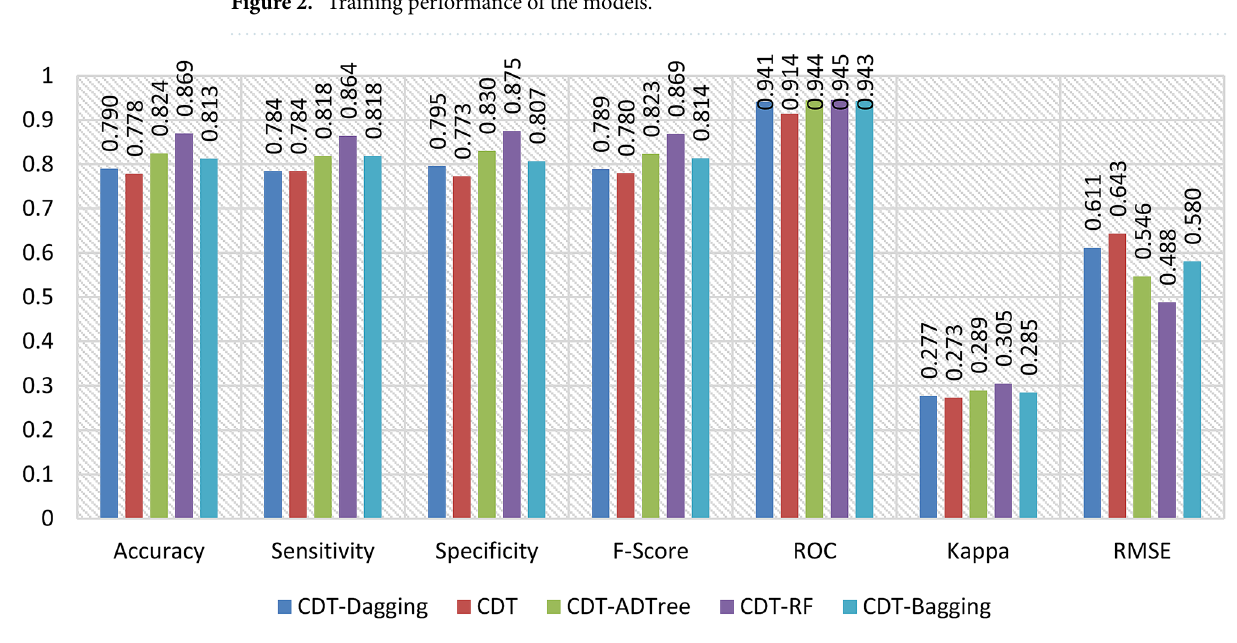
Figure 3. Validation performance of the